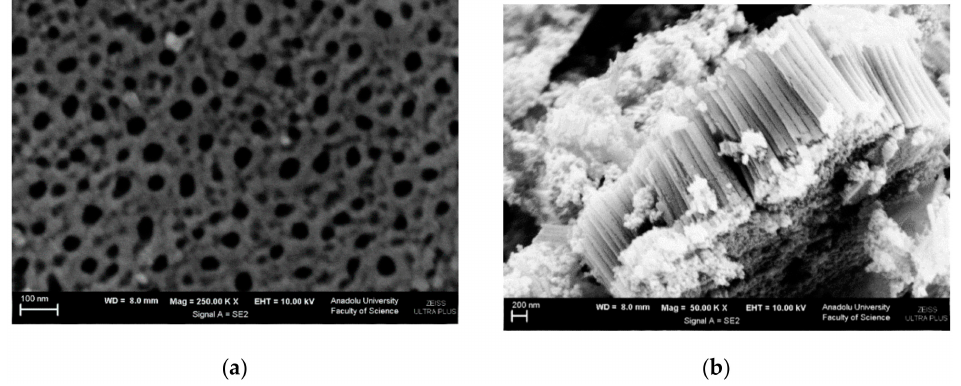
Figure 5. SEM images of Ti/TiO 2 NTEG-1h-500 photoanode: ( a ) top view (magnification: 250,000 × ) and ( b ) cross-section view (magnification: 50,000 × ).